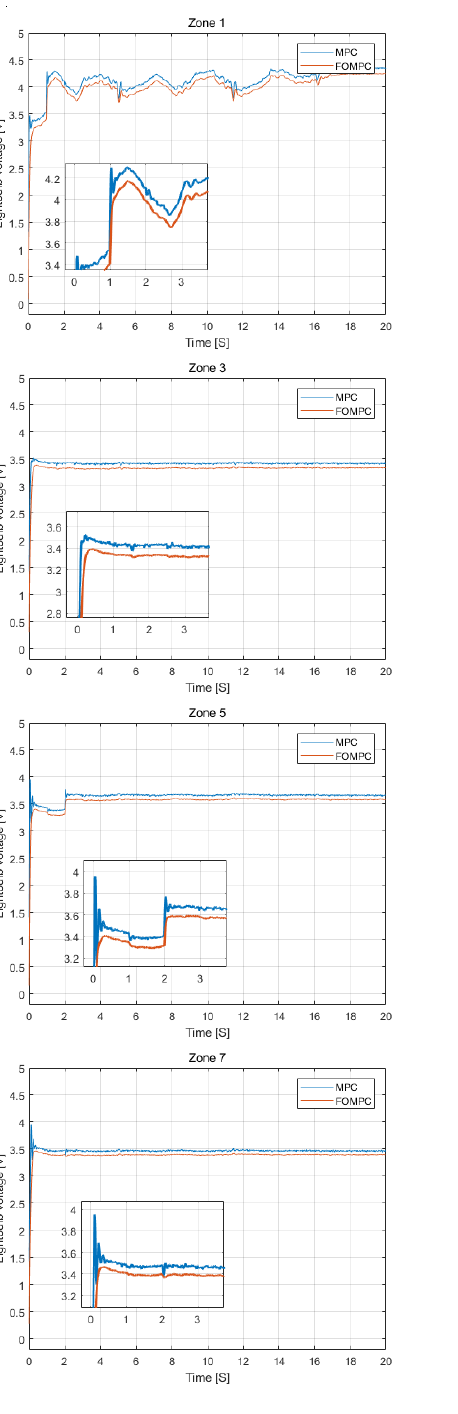
Figure 8. Control input of multiple lighting control with MPC and FOMPC in reference tracking experiment.